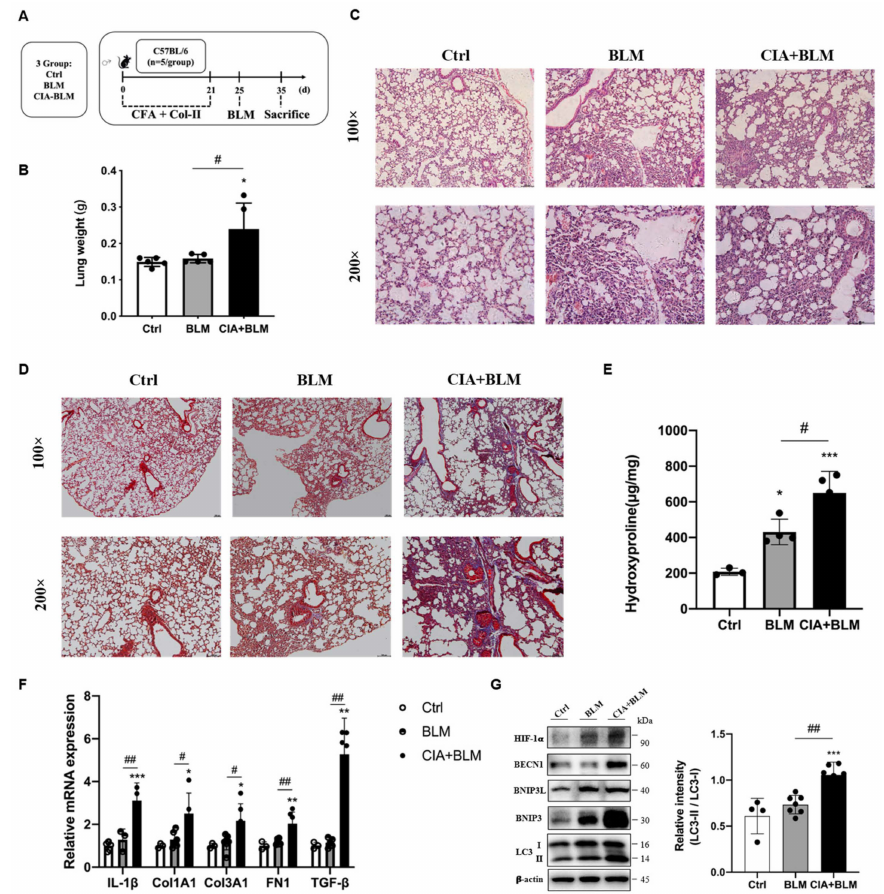
Figure 1. Animal models of RA-ILD were constructed, and the expression of autophagy-related proteins was changed. ( A ) CFA and chicken collagen type II were subcutaneously injected into the tail root of C57BL/6 mice on day 0 and 21 and then treated with bleomycin on day 25. On day 35, the mice were sacrificed. ( B ) The lung weight was measured. ( C , D ) Representative H&E and Masson’s staining images of lungs from the three groups. Scale bars = 50 µ m, shown at 100 × (top panels) and 200 × (bottom panels). ( E ) The levels of hydroxyproline in the lung were measured. ( F ) The mRNA levels of IL-1 β , Col1A1, Col3A1, FN-1, and TGF- β were quantified. ( G ) The levels of HIF-1a, BECN1, BNIP3L, BNIP3, LC3 I, and LC3 II in the lungs were detected using immunoblotting. The ratios of LC3 II/I were quantified as described above. Values represent the mean ± SEM (n = 3–5). Compared with the Ctrl group, * p < 0.05, ** p < 0.01, and *** p < 0.001; compared with the model group (BLM), # p < 0.05 and ## p <